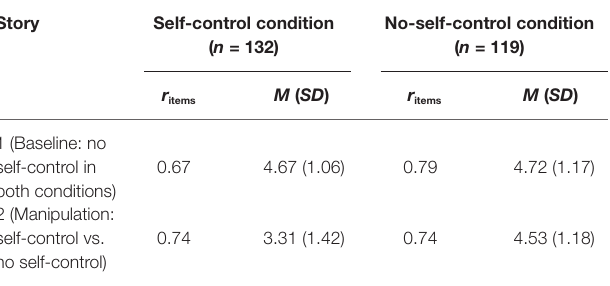
TABLE 2 | Descriptive statistics for the perceived vitality ratings in Study